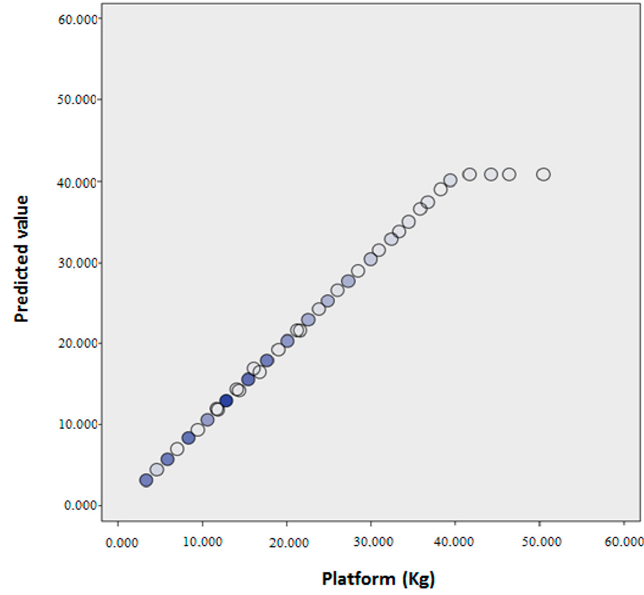
Figure 6. Dispersion graph. Ordenate axis: predicted values by the regression line. Abcissa axis: values recorded by the platform. Color increase in the representation indicates that there are higher values in those in which the variables coincide (0, 10, 20, 30, 40, 50, 60, 70).